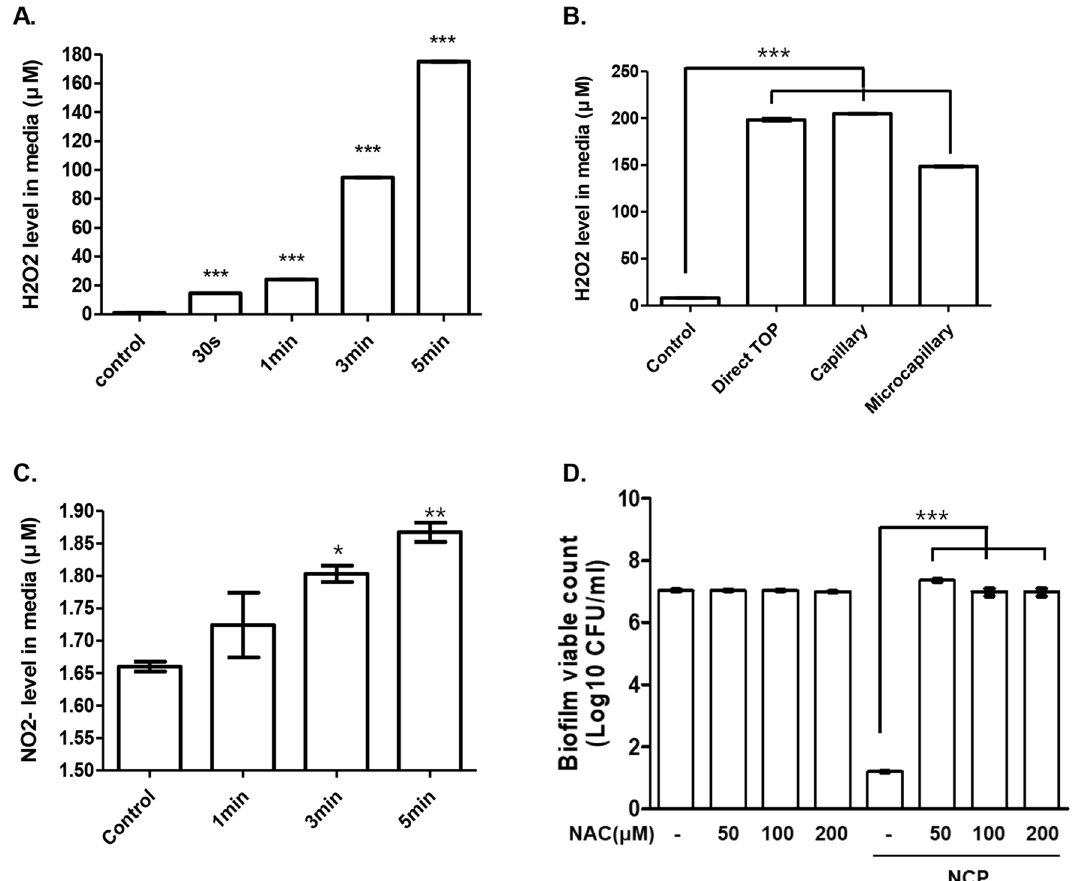
Figure 6. The NCP-mediated increase of H 2 O 2 level in the medium is crucial for the bactericidal effect of NCP in liquid medium. ( A ) The results of the H 2 O 2 concentration measurement. NCP was treated on 1 ml of liquid medium for 0.5, 1, 3, 5 min, and right after the treatment, the H 2 O 2 level of the medium was detected using Amplex red assay kit. ( B ) The liquid medium (1 ml) samples were subjected to un-mounted NCP, NCP mounted with capillary or microcapillary tips for 5 min. After the treatment, H 2 O 2 level in the medium was detected. ( C ) The results of nitrite level detection using Griess assay kit. The liquid medium (1 ml) samples were subjected to the NCP treatment for 1, 3, 5 min, and the NO 2− level in the medium was detected right after the treatment. ( D ) The results of the experiments monitoring the effect of NAC on the NCP-mediated bactericidal effect against S.mutans. The liquid medium samples containing S. mutans were treated with NCP for 5 min in presence or absence of NAC at concentration of 0.2, 0.4, and 1 mM respectively. The treated samples were incubated for 24 h further, and plated on solid medium. At 24 h after the additional incubation, CFU was counted. Data shown are the average of three independent experiments, **p < 0.05, **< 0.01, ***< allows the bactericidal effect of NCP to be maintained, various types of dental tips were mounted on the NCP device, and the bactericidal efficacy of NCP against S. mutans was investigated. Various types of dental tips that are actively used in the field of dentistry were prepared, and the pore size and length of the tips were analysed, as shown in Fig. 9A. Subsequently, each dental tip was mounted on the NCP device, and a 5 min NCP treatment was performed at fixed conditions, where a 1 cm distance was maintained between the tip end and the solid medium inoculated with S. mutans ; a clear zone was formed, and its size was monitored 24 h after the treat- ment. As shown in Fig. 9B, although dental tips numbered 1 to 3 were of the same tip material and length, NCP treatment with tip number 1 (22 gauge) failed to form a clear zone, whereas that mounted with tip numbers 2 (20 gauge) and 3 (18 gauge) yielded clear zones, indicating the importance of the pore size. The NCP treatment with tip number 4, which was a 20-gauge-pore bent metallic tip, yielded a clear zone. In the NCP treatments